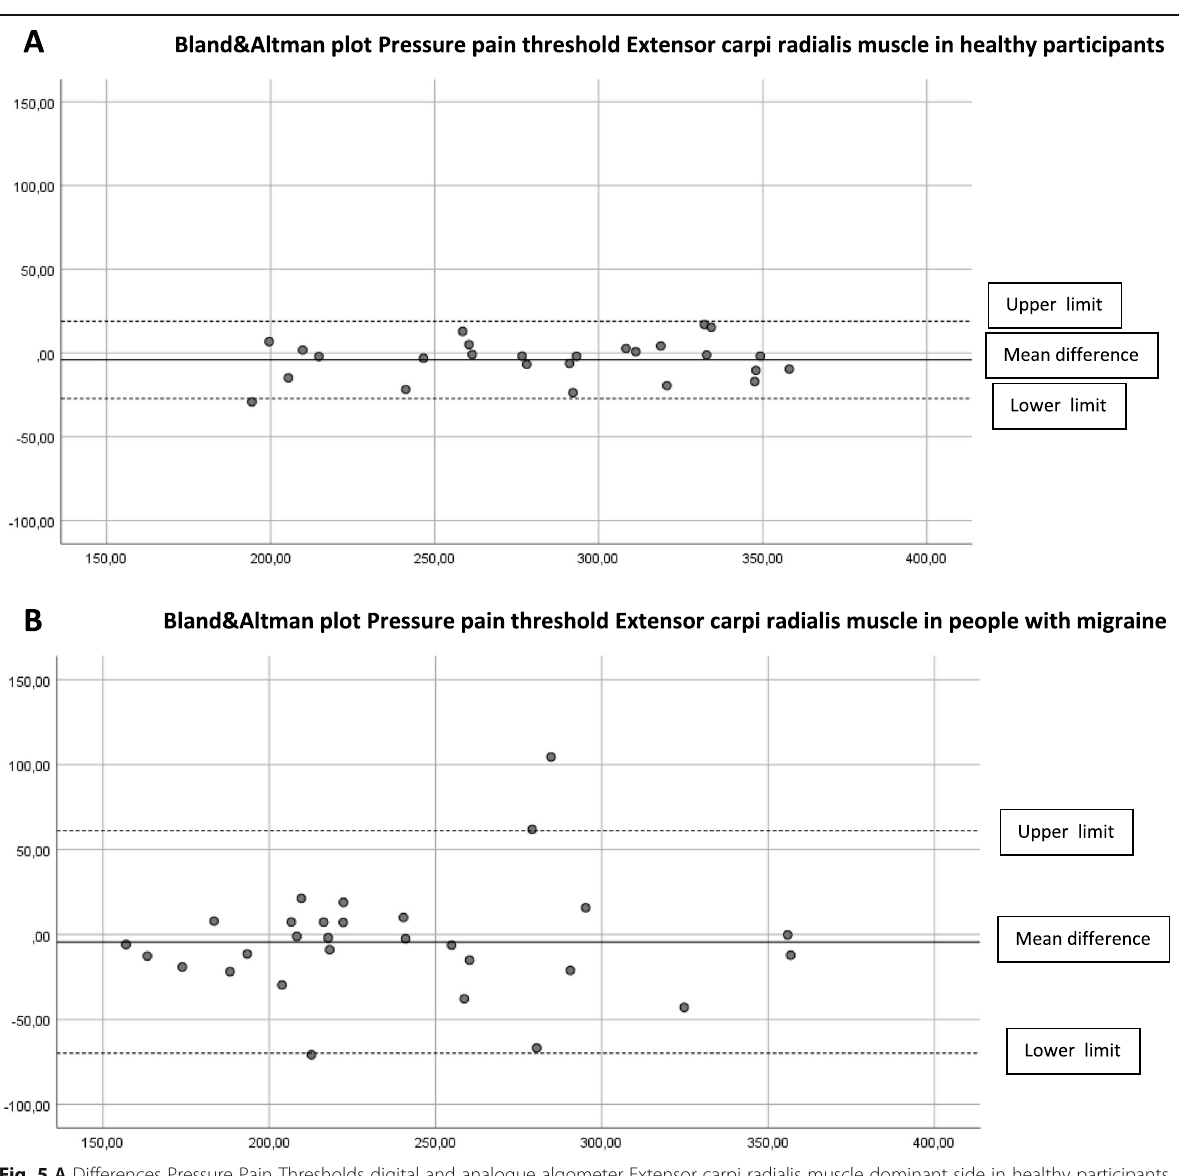
Fig. 5 A Differences Pressure Pain Thresholds digital and analogue algometer Extensor carpi radialis muscle dominant side in healthy participants (mean difference, upper and lower limit). B Differences Pressure Pain Thresholds digital and analogue algometer Extensor carpi radialis muscle dominant side in people with migraine (mean difference, upper and lower